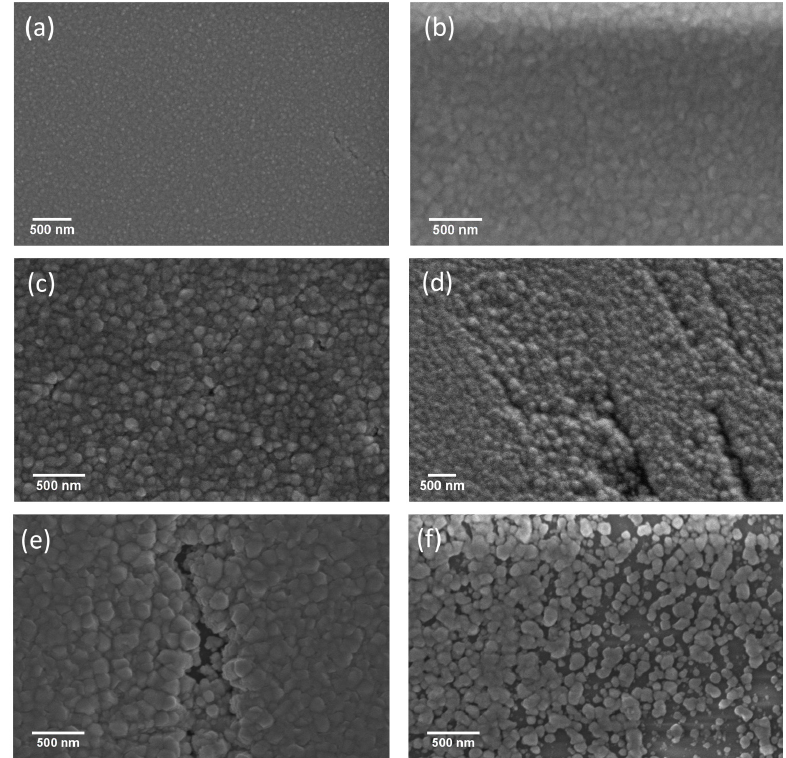
Figure 1. SEM images of nanostructured CdS thin films deposited at different substrate temperatures: ( a ) 25 °C; ( b ) 50 °C; ( c ) 100 °C; ( d ) 150 °C; ( e ) 200 °C and ( f ) 250 °C.